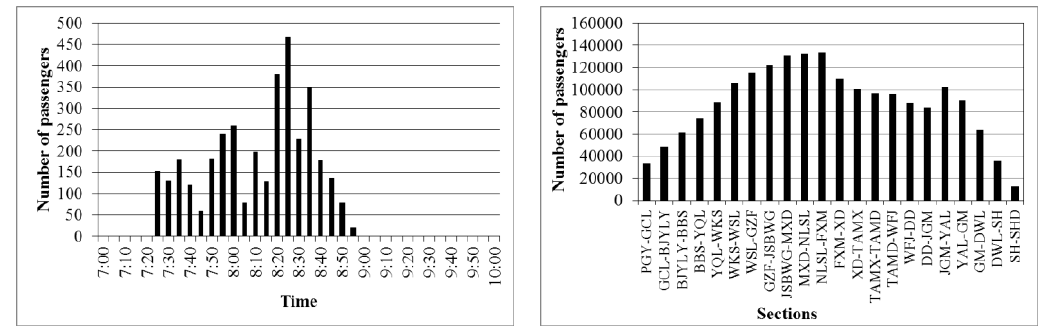
Figure 9. remainder passengers at XD station Figure 10. Section flow of Line